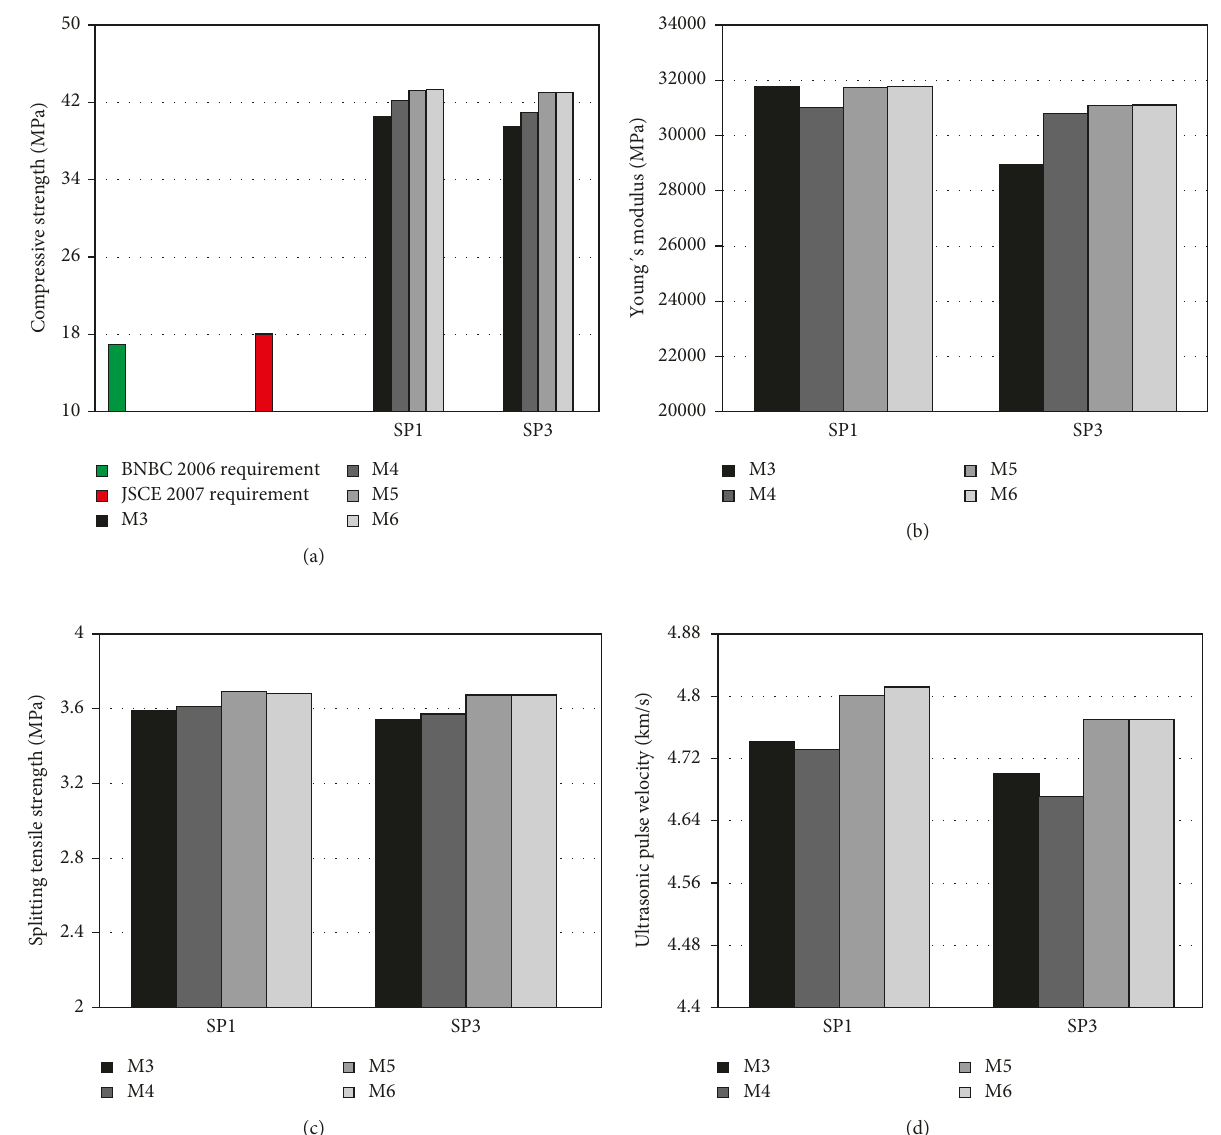
Figure 5: Hardened properties of M3, M4, M5, and M6 concretes at the age of 28 days: (a) compressive strength, (b) Young’s modulus, (c) splitting tensile strength, and (d) ultrasonic pulse